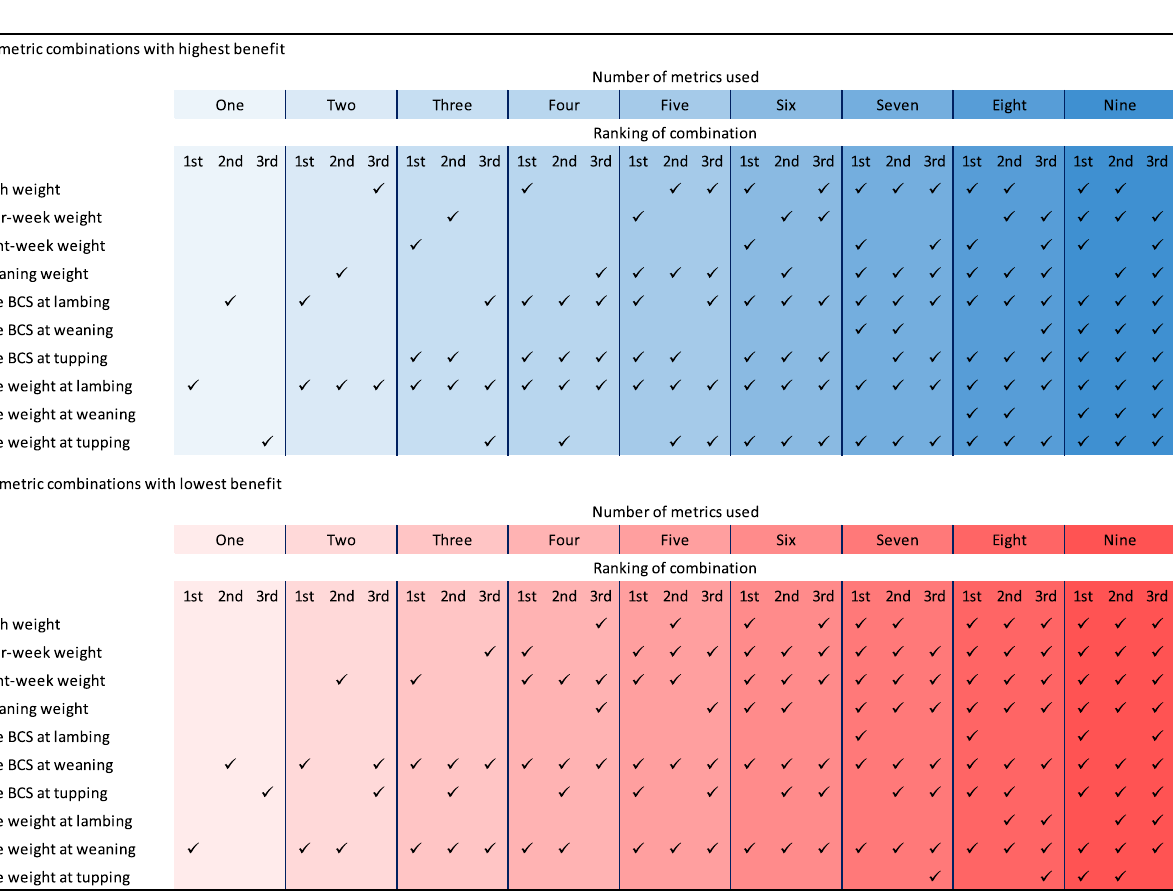
Figure 2. Combined gross information value of multiple predictors. A considerable variability in information value is observed even when the same number of predictors is used, demonstrating the importance of selecting key performance indicators based on quantitative evidence.